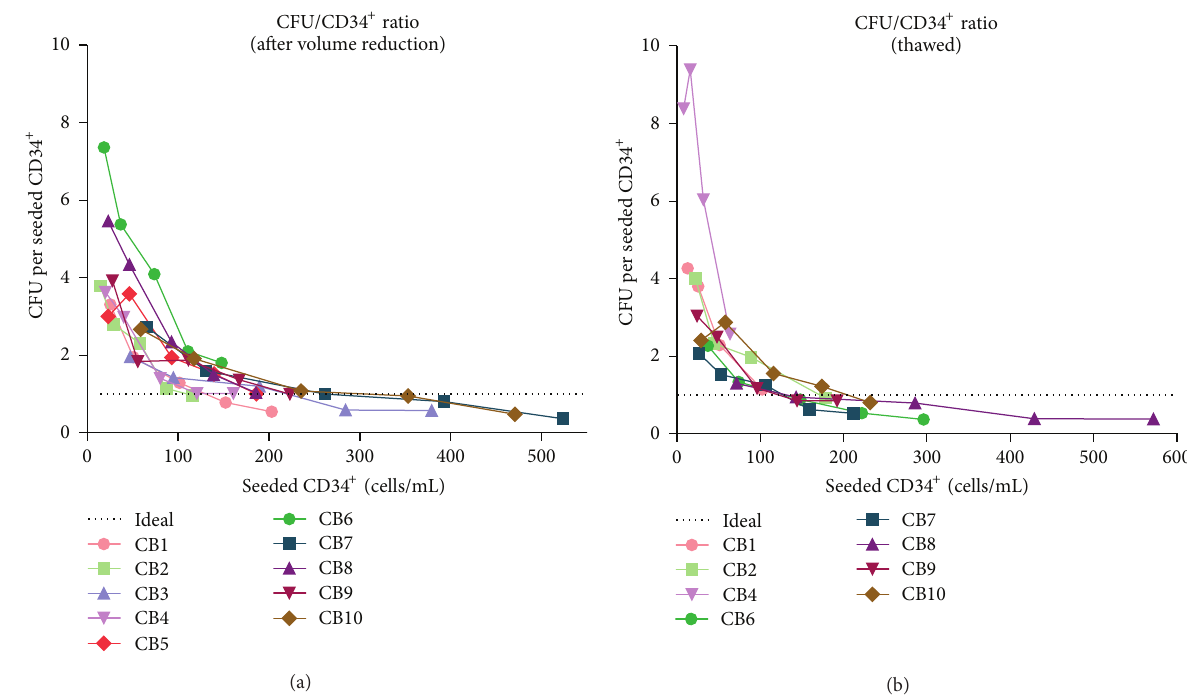
Figure 5: The reproducibility of ClonE for different samples is dependent on seeding density. When less than 100 CD3 4 + cells were seeded per mL, the resulting ratios were extraordinarily high and varied stronger than those with higher seeding density. Only in the range from 100 to 200 CD34 + /mL, constant ratios were observed close to the theoretically expected value of 1:1 (dotted line), while higher densities lead to lower ClonE values, probably due to limiting effects as well as impaired